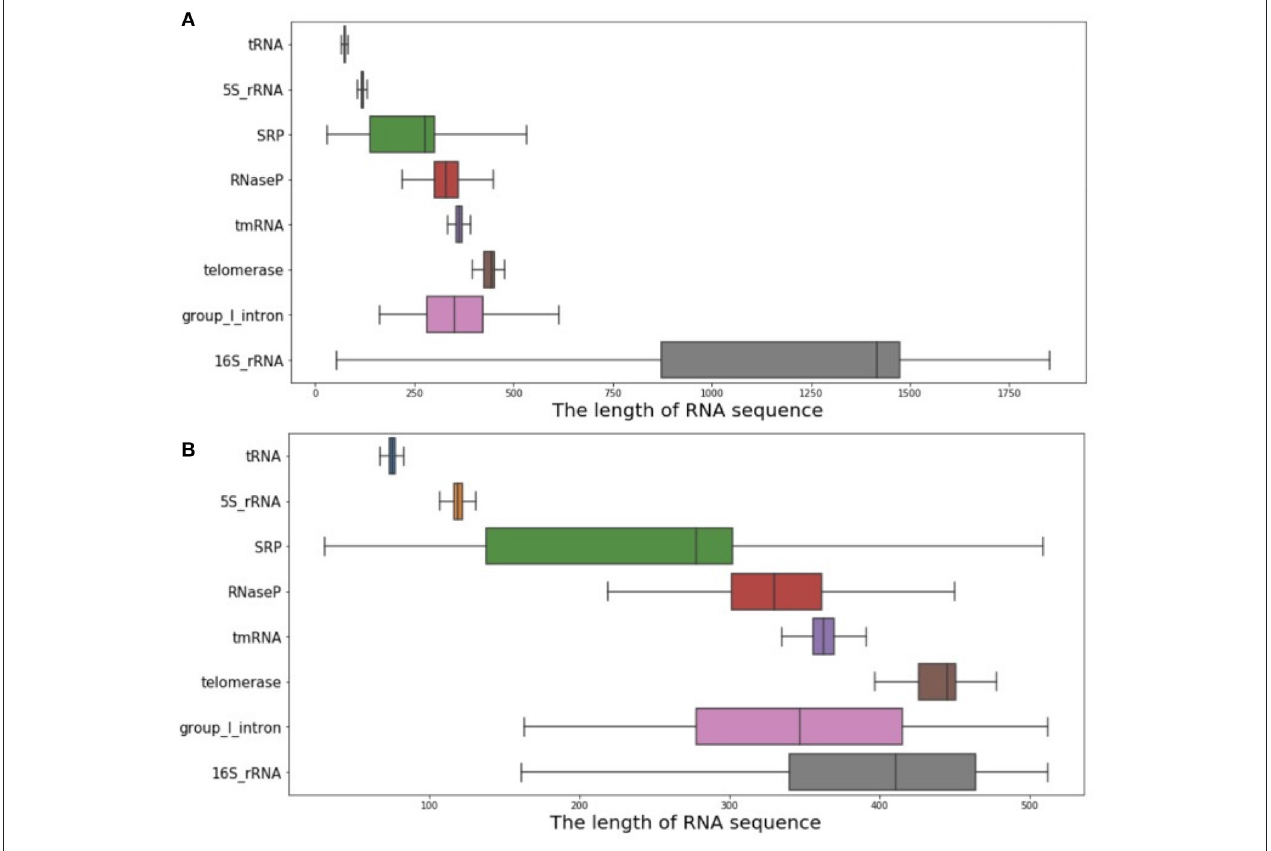
FIGURE 4 | RNA sequence length analysis chart. (A) shows the distribution of the length of all RNA sequences of the eight RNA families. (B) shows the distribution of RNA sequence length within 512.